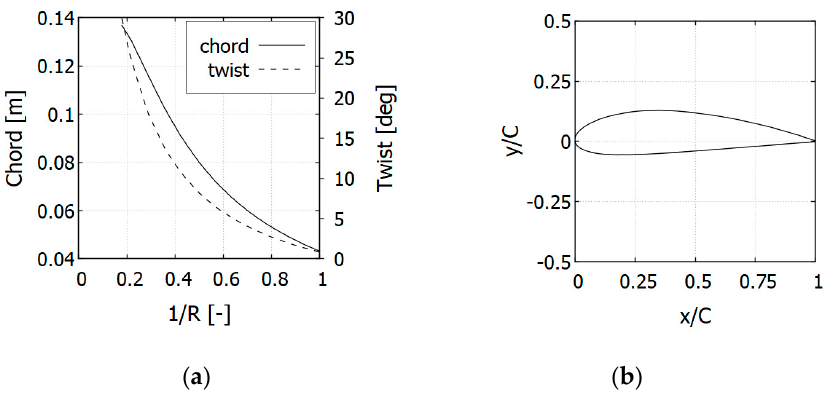
Figure 1. Twist and chord distributions ( a ); selected airfoil NACA 4418 ( b ).